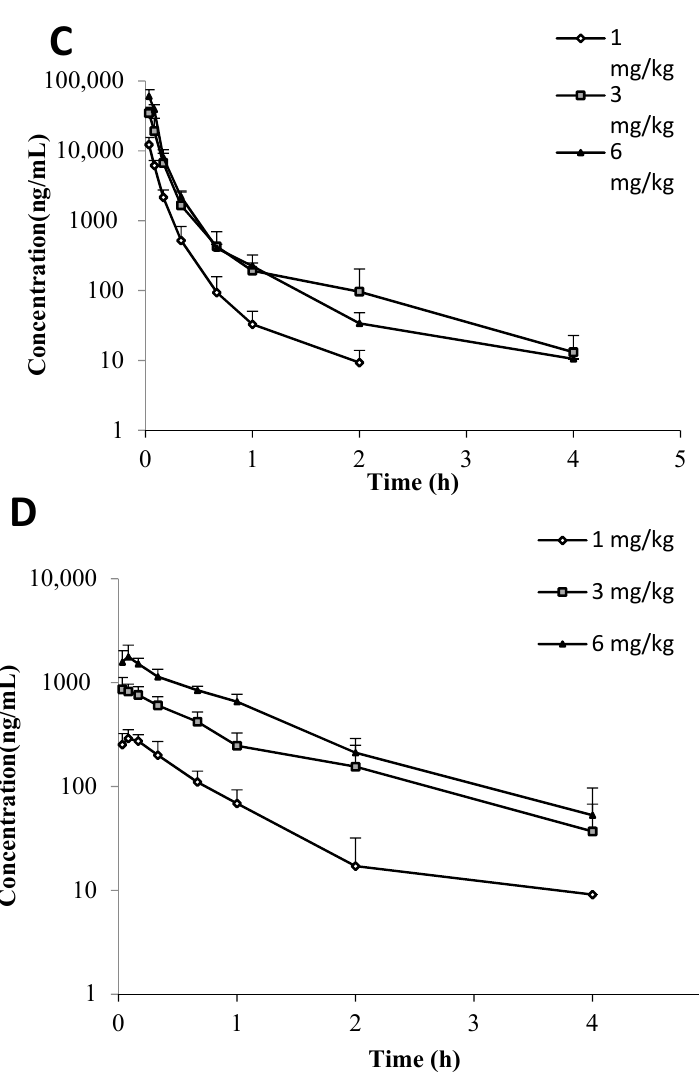
Figure 2. Plasma-concentration-versus-time profiles of C118P in rats ( A ), C118 in rats ( B ), C118P in dogs ( C ), and C118 in dogs ( D ) after i.v. injection of C118P. Doses were 5, 10, 20, and 50 mg/kg in rats and 1, 3, 6 mg/kg in dogs, respectively. Data are presented as the arithmetic mean ± SD ( n = 6). Data are not illustrated in the figure due to levels below the lower limit of quantification (LLOQ, 5 ng/mL).